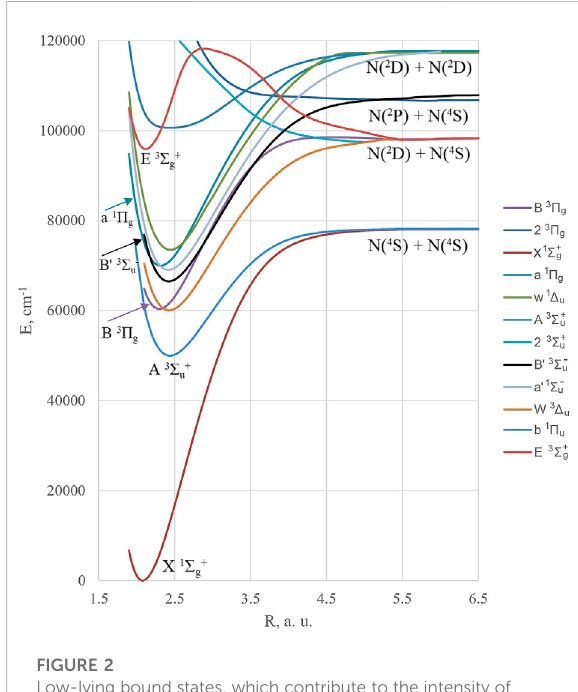
FIGURE 2 Low-lying bound states, which contribute to the intensity of the studied